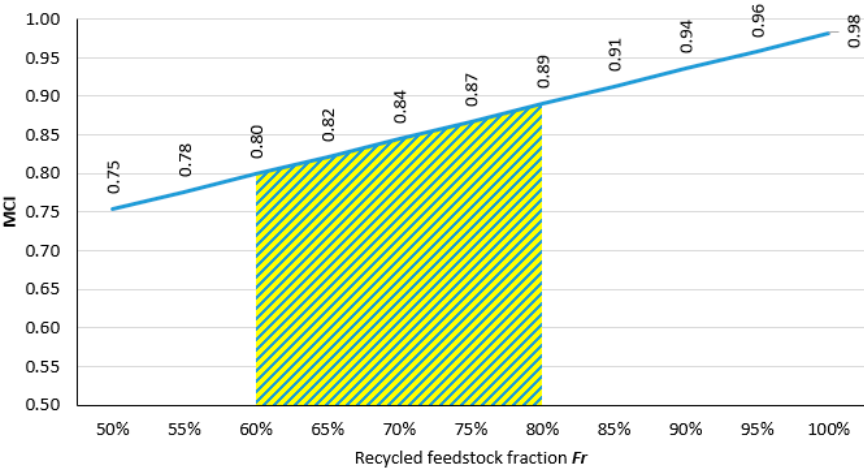
Figure 7. Relationship between the recycled feedstock fraction F r and the MCI in the studied 3D part. The recommended area for a piece of sufficient quality has been shaded.